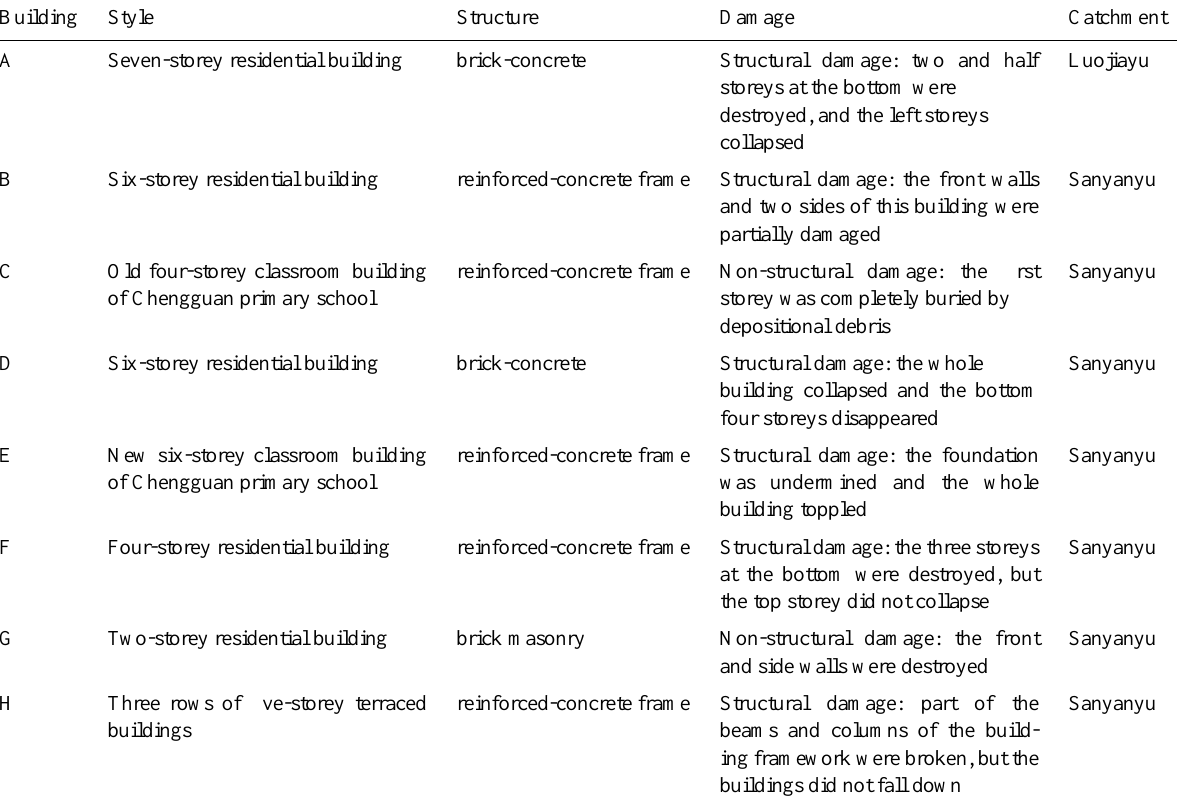
Table 2. Description of damage to the eight buildings by debris